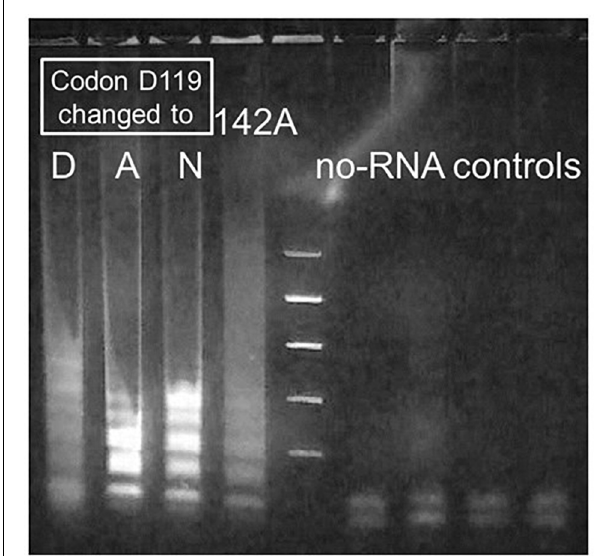
FIGURE 4 | Sharpening of fuzzy bands produced by Taq D732N catalyzing RT-LAMP. MS2 RT-LAMP under conditions as for Figure 3 , reacted for only 51 min, catalyzed by four differently mutated enzymes. Codon 732 was D732N and enzyme was full-length Taq pol for all lanes. Lane 1: D119D, i.e., wild-type at codon 119. Lanes 2 and 3: mutations D119A and D119N. Improved clarity of the banding pattern, to make it similar to that observed for standard LAMP, was the result if these mutations near a metal-binding site of the 5 (cid:48) -exonuclease (5 (cid:48) -flap endonuclease) were present in the enzyme. As shown, mutation D142A failed to have this effect.